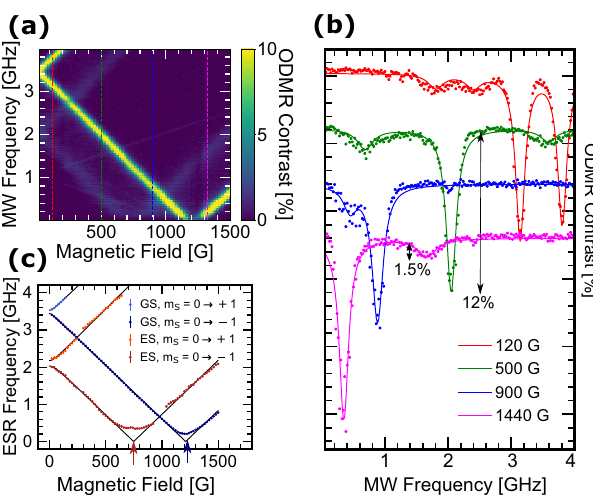
Fig. 2 Room temperature fi eld dependence of CW ODMR and spin resonance frequencies. a Magnetic- fi eld dependence of the CW ODMR contrast at room temperature. b Individual ODMR traces and their fi ts at four values of B 0 indicated by the vertical colored dashed lines in a . c Field dependence of the fi tted ODMR peaks corresponding to the electron spin resonance (ESR) frequencies. Error bars represent the standard deviation of the fi tted parameter. Fits to Eq. (2) are shown in black. The fi eld magnitudes at which the 0 j i and (cid:1) 1 j i spin states cross in energy are marked with red and blue ES data. We fi t the ESR data with Eq. (2) to extract the Hamil- tonian parameters. Our measurements agree with previously reported 16,23,26,41 GS splitting parameters D gs = 3.48 ± 0.02 GHz and E gs = 48.0 ± 7.1 MHz, and establish the ES splitting para- meters D es = 2.11 ± 0.03 GHz and E es = 74 ± 42 MHz. We also observe that g es ≈ g gs ≈ 2, which indicates that the orbital angular momentum does not play a signi fi cant role in the ES spin structure. The average ES linewidth over the fi eld sweep at this microwave power is 133 ± 32 MHz. These measurements were taken at multiple locations from three different hBN fl akes with repeatable results. We do not resolve hyper fi ne splitting in the ES possibly due to power broadening, the short ES lifetime, and inhomogenous broadening in the defect ensemble. Based on the observed linewidth, we estimate an upper limit of ~100 MHz for the ES hyper fi ne splitting. To verify our attribution of the additional ESR frequencies to spin transitions within the orbital excited-state, we implement a pulsed ODMR sequence to compare with CW ODMR results. In the CW measurement, we apply simultaneous microwave and optical excitation (Fig. 3a), allowing spin rotations to occur both in the GS and in the short time interval spent in the ES, resulting in ODMR contrast at the GS and ES ESR frequencies. In the pulsed measurement, the signals are timed such that the micro- wave pulse trails the optical excitation pulse by a delay that is much longer than the ES lifetime (1 – 2 ns) (Fig. 3c). In this case, the ES population is negligible when the microwave fi elds are applied and consequently, the ODMR contrast at the ES ESR frequency disappears if one of the observed spin transitions occurs in the ES. We achieve this by pulsing the laser excitation for 20 μ s followed by a waiting period of 5 μ s to ensure that the ¼ 0 spin defects have relaxed to the orbital GS with a m V (cid:1) S B polarization. While in the dark, we apply a 500 ns burst of B MW , followed immediately by a 1 μ s laser pulse and photon collection for readout. We sweep the frequency of B MW from 2 to 4 GHz with a step size of 10 MHz and repeat the measurement ~10 4 times at each frequency to build statistics. The results of the CW